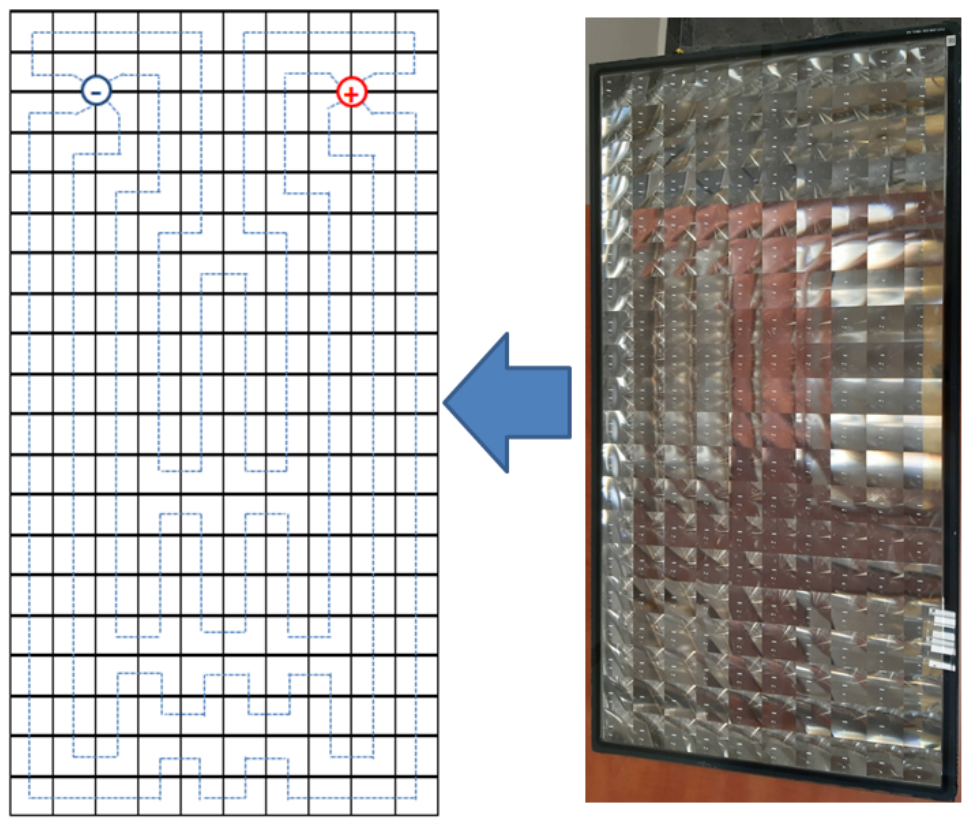
Figure 1. Appearance and design of internal cell connections in CX-75/200 module.